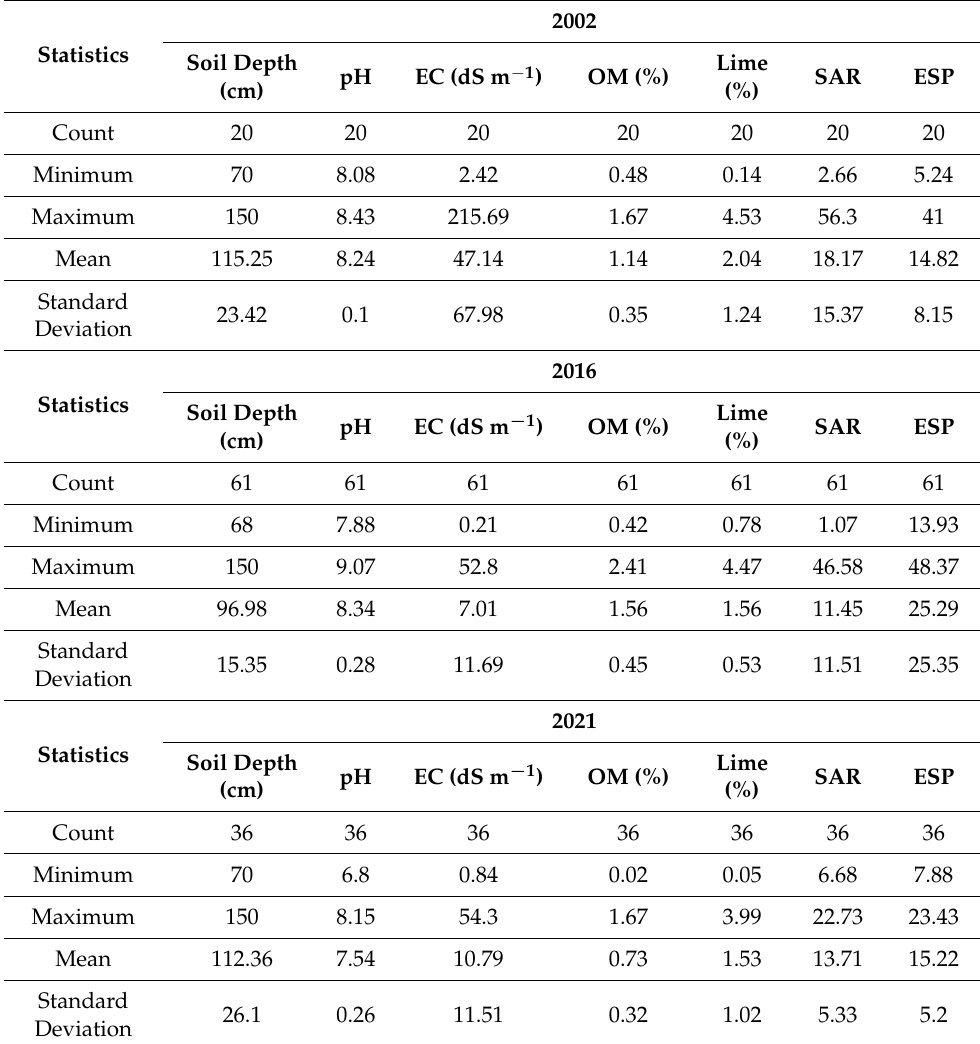
Table 1. Analysis of soil samples used to verify the results of the proposed